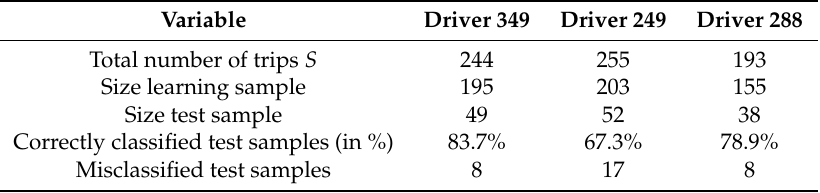
Table 5. Out-of-sample analysis of drivers 249, 349 and 288.